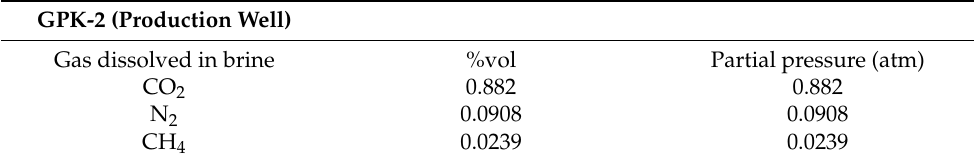
Table 2. Composition of gas in brine at the production well of the SsF geothermal plant [7]. GPK-2 (Production